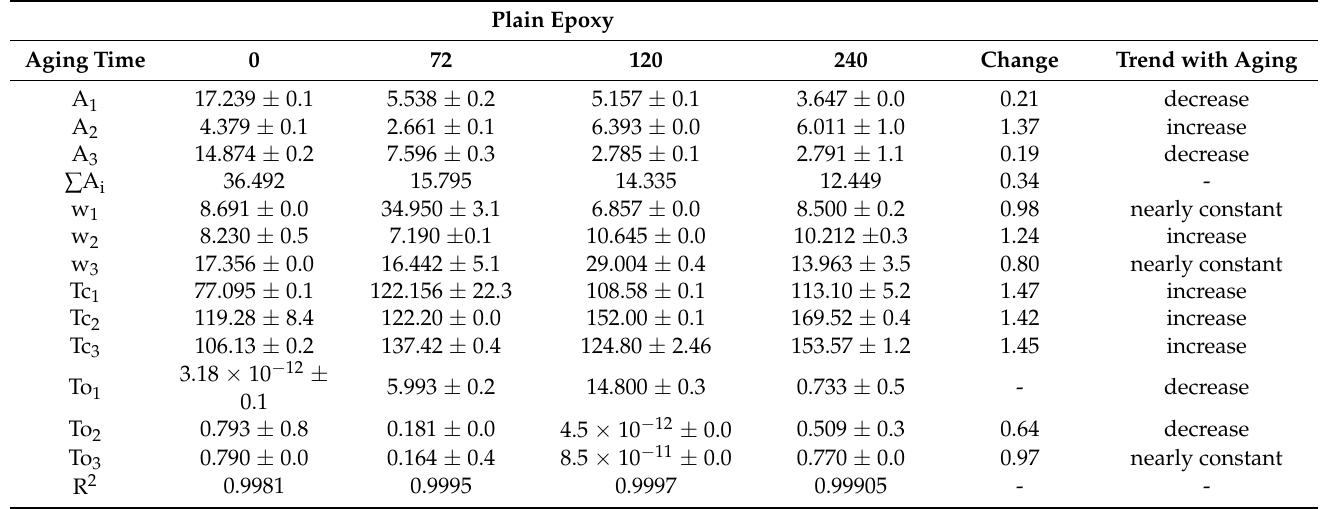
Table 4. EMG fit parameters of the loss factor curves for plain epoxy as a function of aging at high temperature. The column named ‘change’ gives the ratio of values between the aged state at 170 ◦ C, 240 h, and the unaged state.